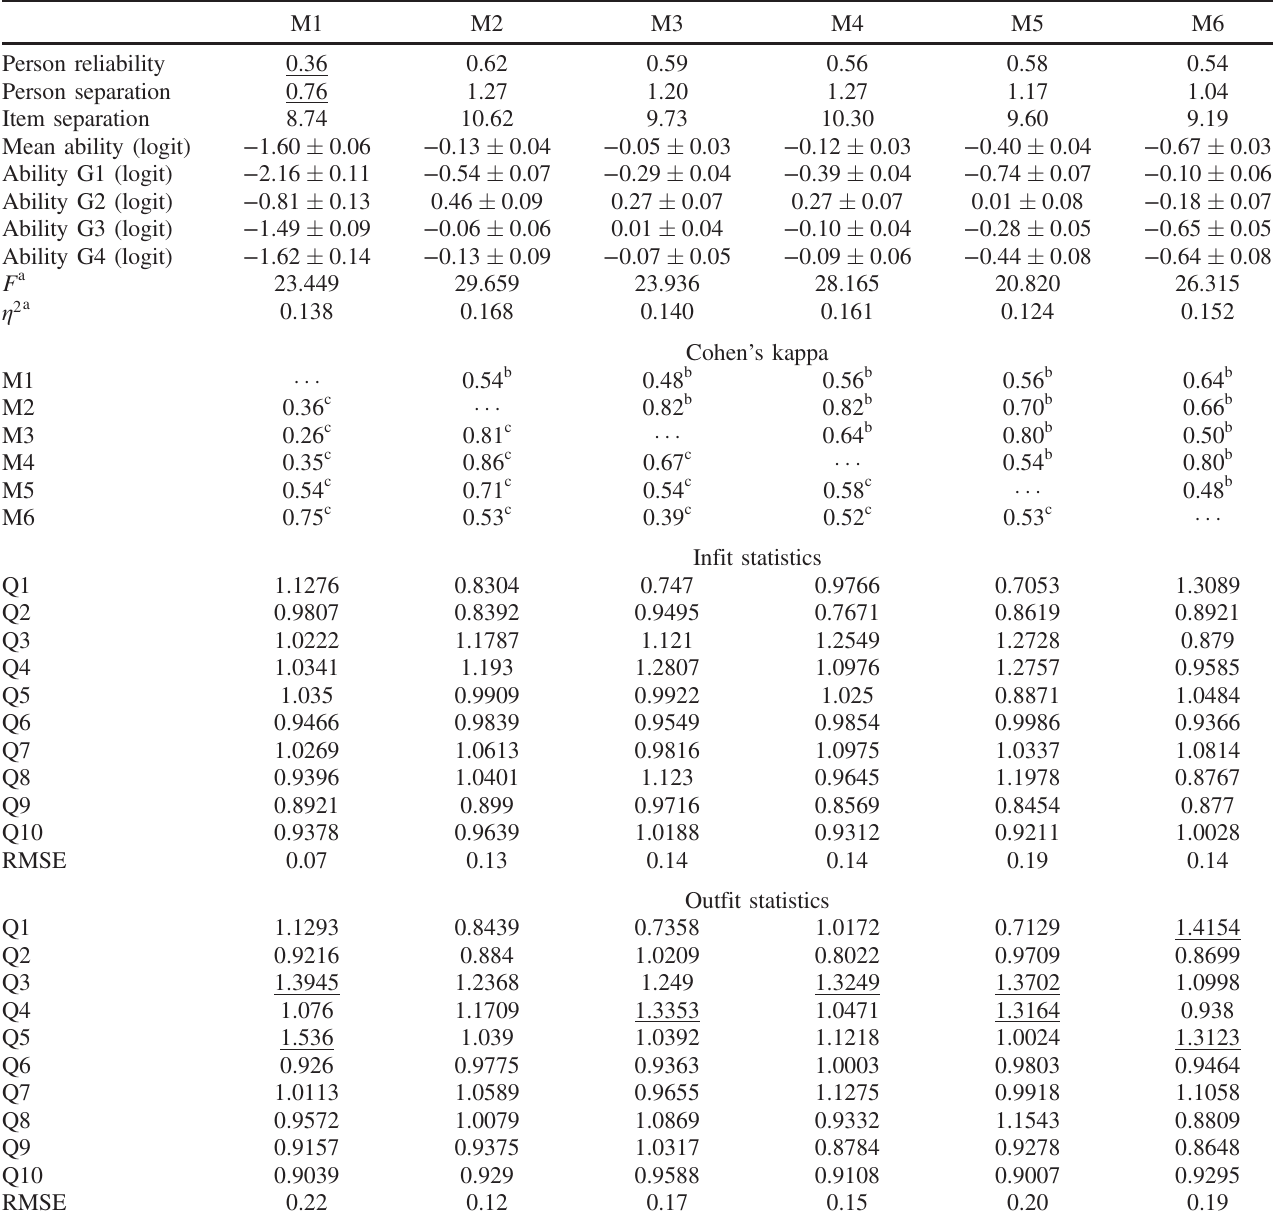
TABLE IX. Rasch analysis statistics for QME (tiers analyzed